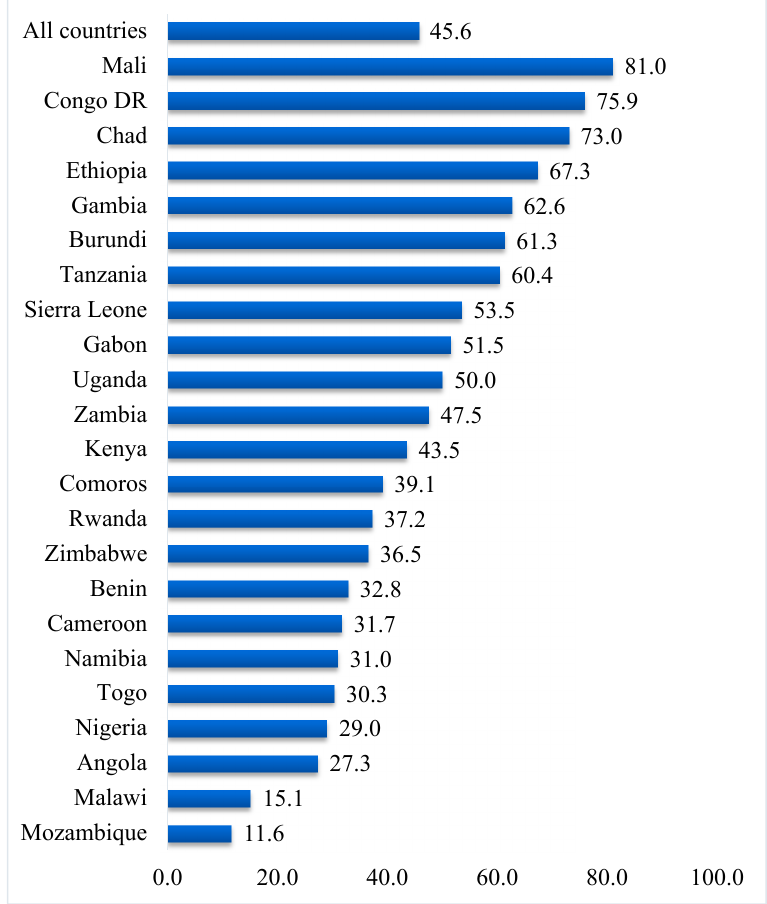
Figure 2. Prevalence of supportive attitude towards intimate partner violence (%).